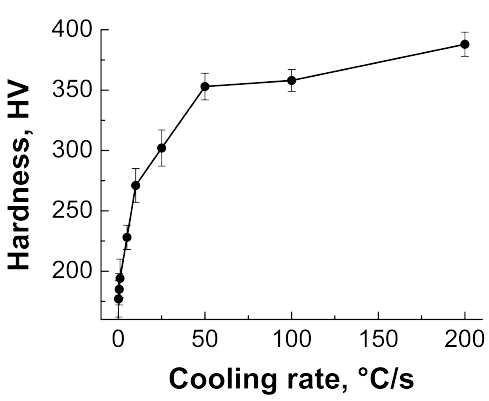
Figure 9. Evolution of the micro-hardness as a function of the cooling rate from the intercritical temperature at 800 ◦